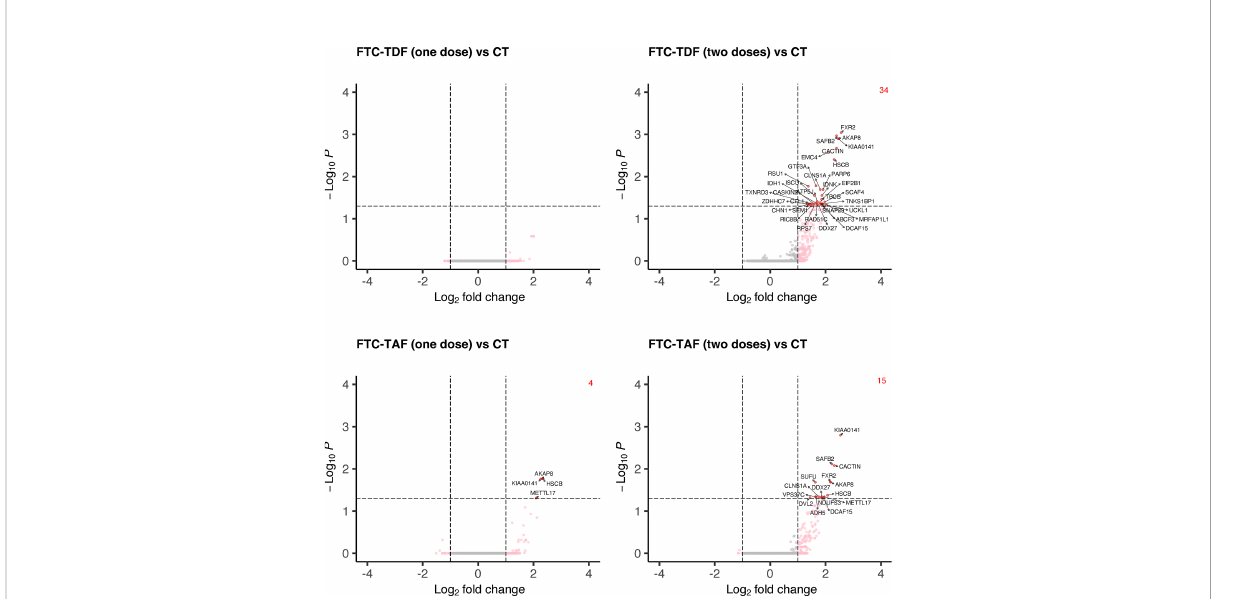
FIGURE 6 Differential gene expression analysis comparing merged PrEP arms receiving different drugs and doses with control arm. Specimens from both South Africa and Uganda were grouped by the type of PrEP and number of administered doses. The expression of all transcripts was then compared to the control arm and statistically signi fi cant DEGs and their number are shown in red.